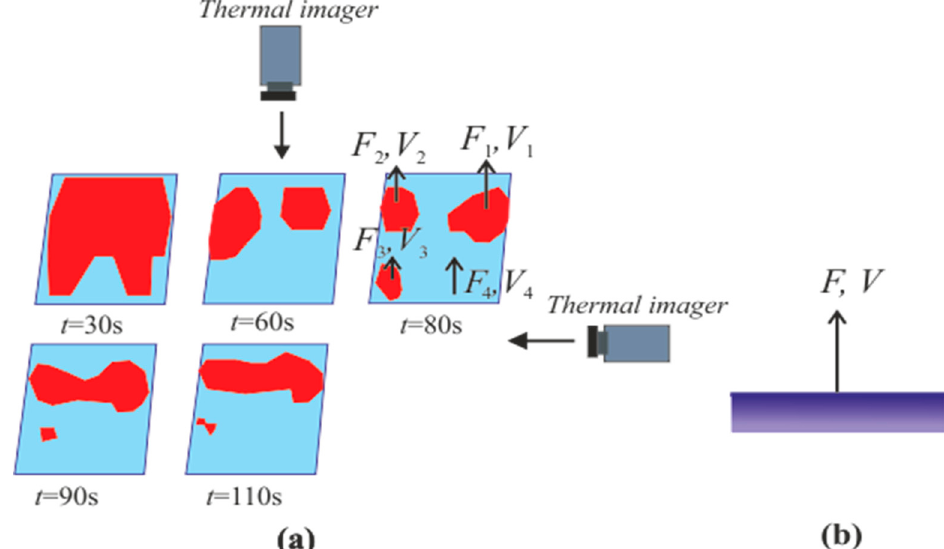
Figure 13. ( a ) “Effective area” of methane hydrate combustion (red); and ( b ) average methane velocity V from the entire surface area of layer F .